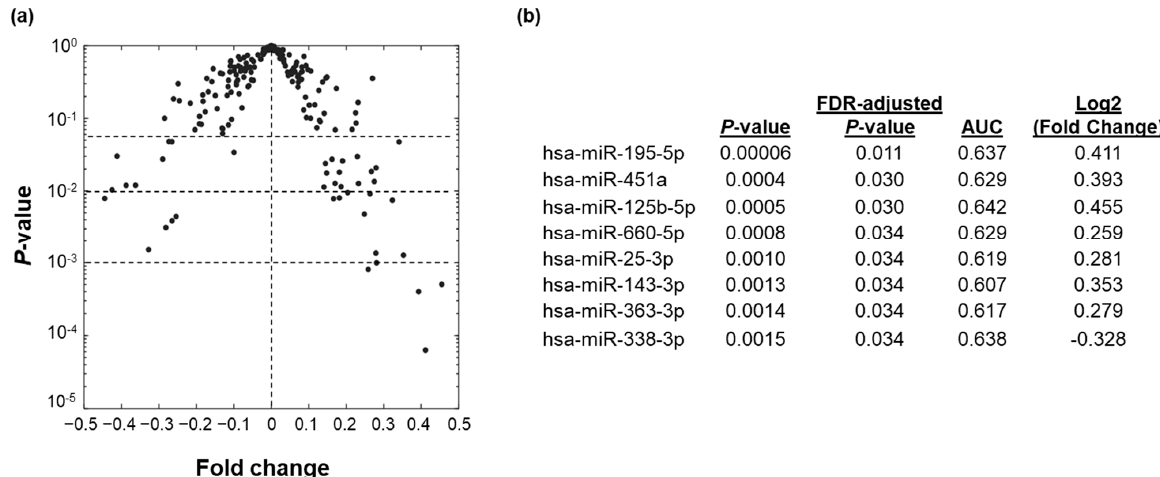
Figure 1. Biomarker discovery. ( a ) Differential miRNA expression in patients with breast cancer compared to those with benign breast lesions as determined by fold change of miRNA expression and statistical significance ( p -value). ( b ) Differentially regulated miRNAs in patients with breast cancer compared to those with benign breast lesions (statistical significance determined by FDR-adjusted p -value < 0.05). Ability of miRNA biomarker in distinguishing between breast cancer and benign breast lesions was measured by area under the ROC curve (AUC).